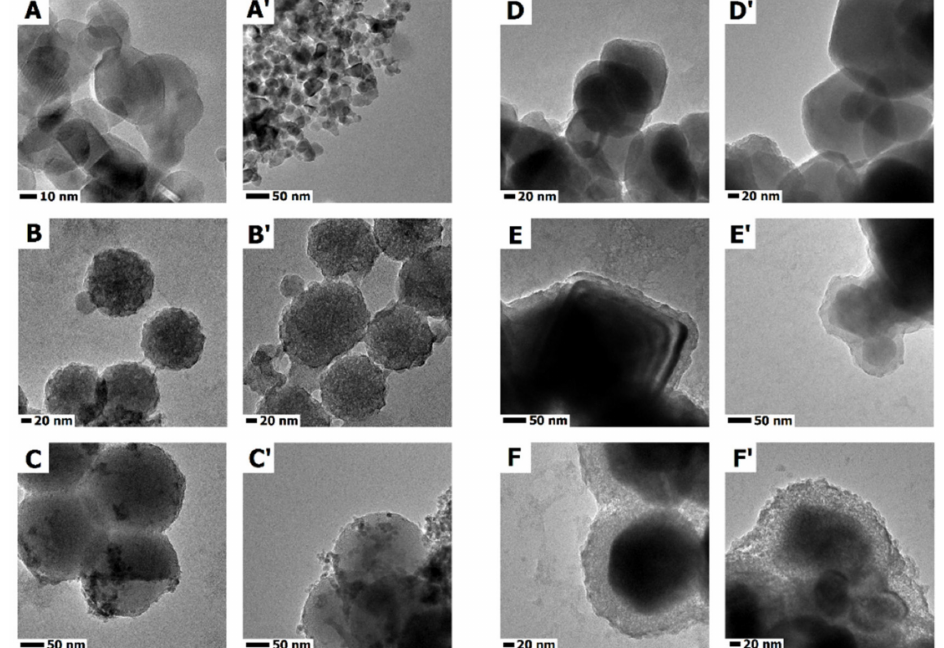
Figure 1. TEM images of titanium dioxide ( A , A’ ); mesoporous silica spheres ( B , B’ ); mesoporous silica spheres modified with titanium dioxide ( C , C’ ); iron oxide particles ( D , D’ ); covered with mesoporous silica shell before ( E , E’ ) and after functionalization with titanium dioxide ( F , F’